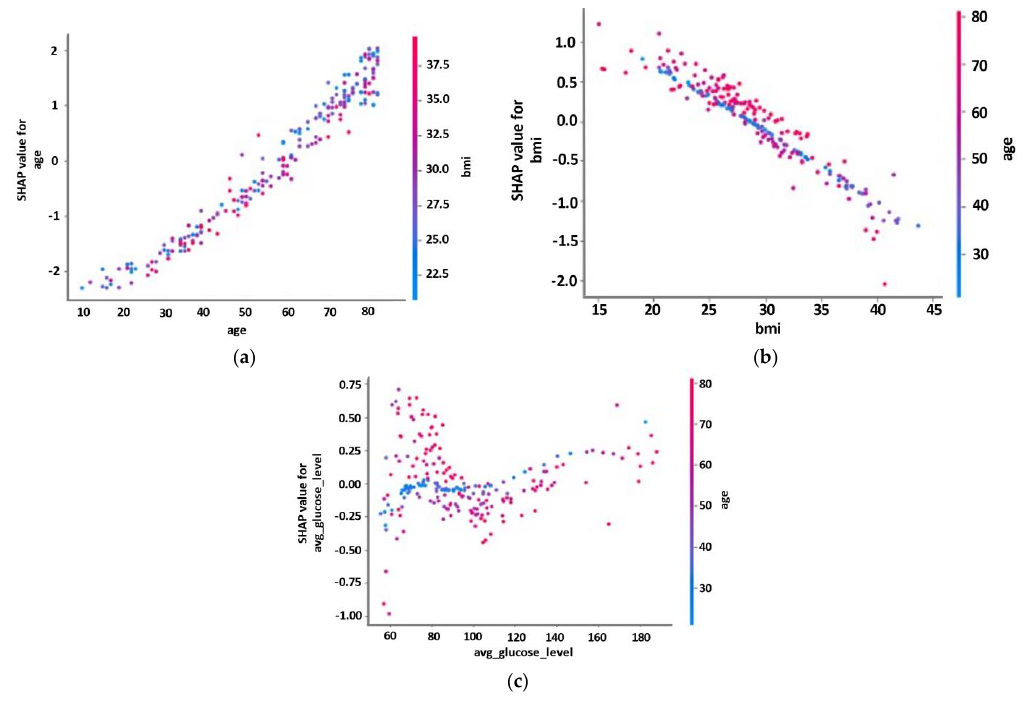
Figure 6. SHAP dependence plots of three representative risk factors: ( a ) age; ( b ) BMI; ( c ) avg_glu-